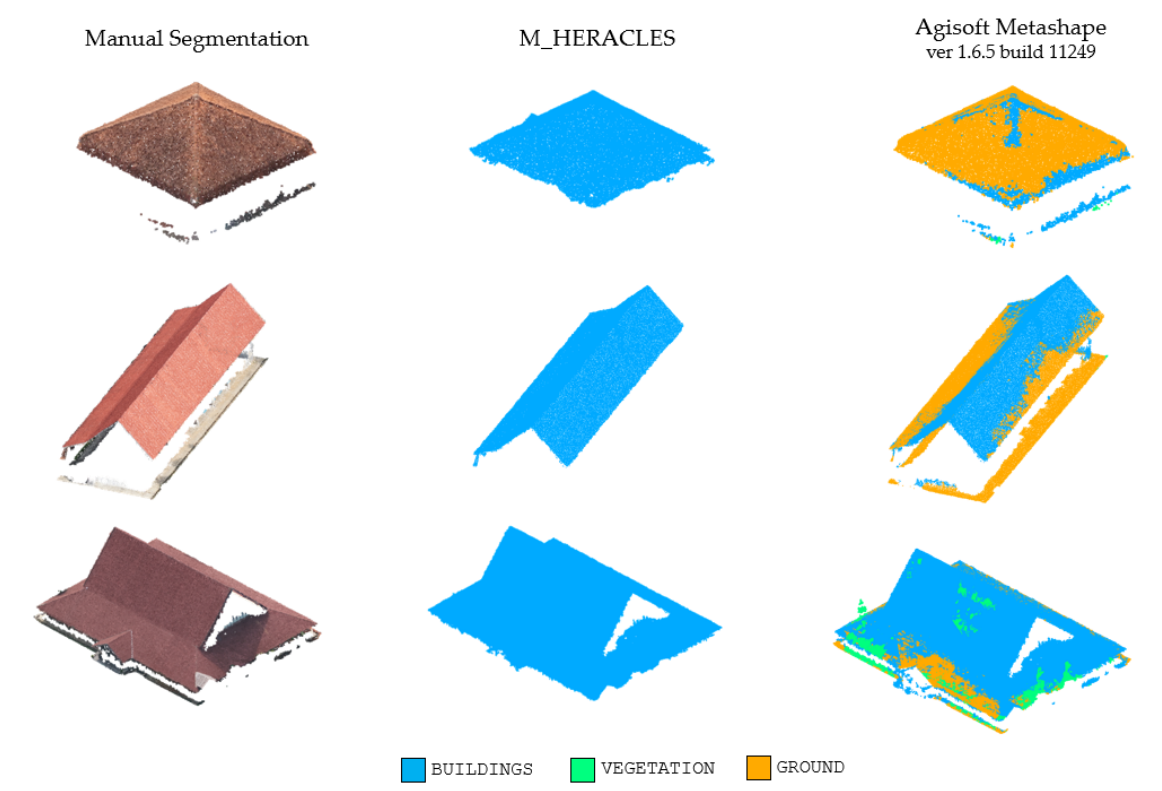
Figure 5. Three examples of the segmented building/roof clusters in ascending level of roof complexity. Note that M_HERACLES employs a winner-takes-all approach, hence the homogeneous semantic annotation. On the contrary, Metashape displays a case of mis-classification mostly between the “ground” and “building” classes.